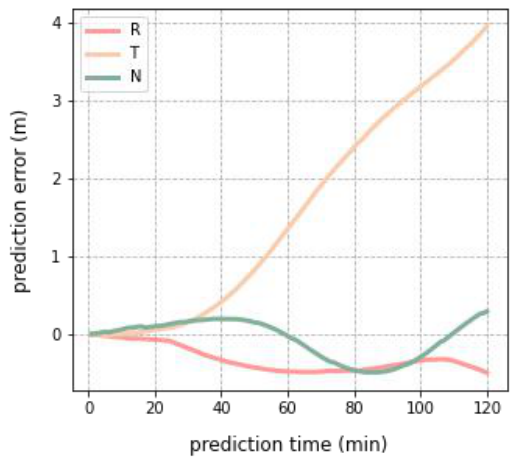
Figure 2. Prediction error in 3 directions of GRACE in 120 minutes prediction.